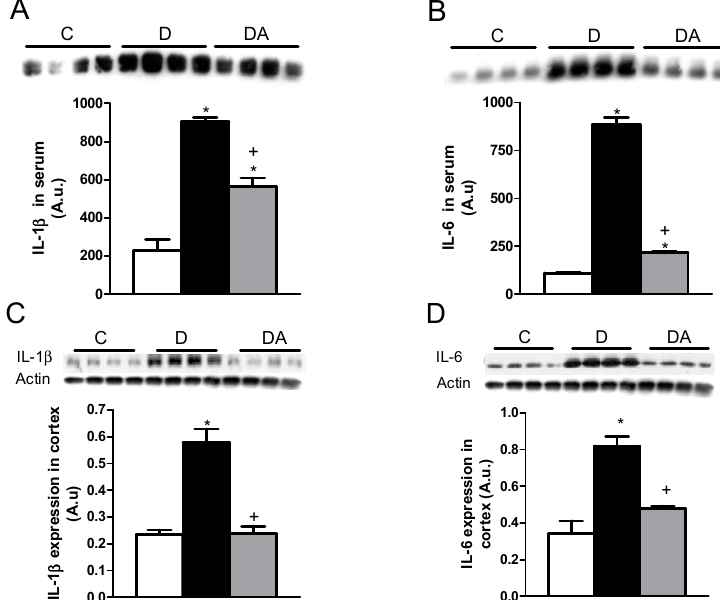
Figure 4. Effects of allicin on proinflammatory cytokines in serum with expressions of interleukin 1 beta (IL-1 β ) ( A ) and interleukin 6 (IL-6) ( B ) and in cortex with expressions of IL-1 β ( C ) and IL-6 ( D ). C, D and DA in figures represent the control, untreated diabetic and allicin-treated diabetic groups, respectively. Data represent the average of values from all the animals ( n = 6) in a given group ± SEM (* p < 0.05 vs. the control group; + p < 0.05 vs. the diabetic groups).